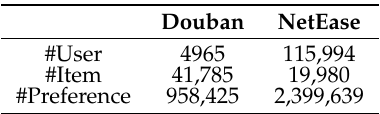
Table 2. Dataset